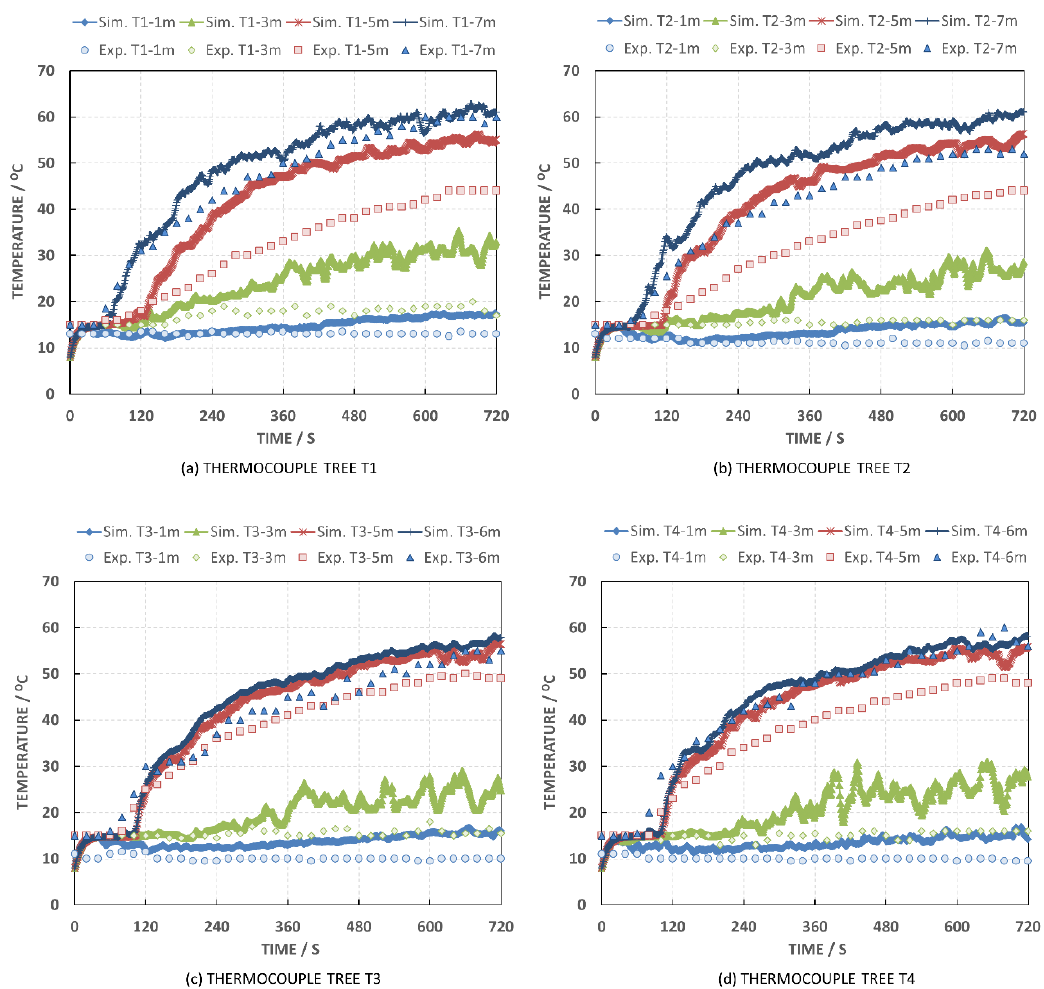
Figure 5. Comparison of the numerical prediction against the experiment temperature measurements for Case 1 at thermocouple trees ( a ) T1, ( b ) T2, ( c ) T3, and ( d ) T4.